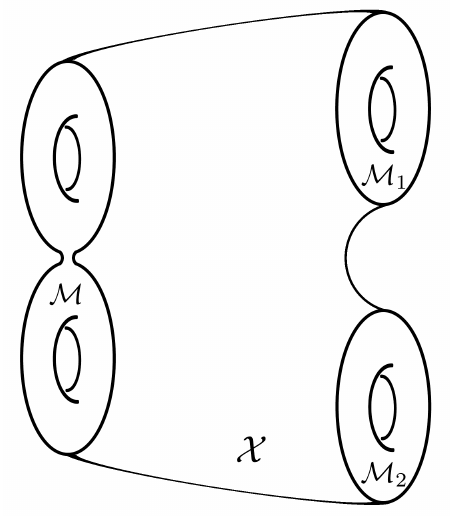
Figure 24: The 3D manifold X with boundaries M M